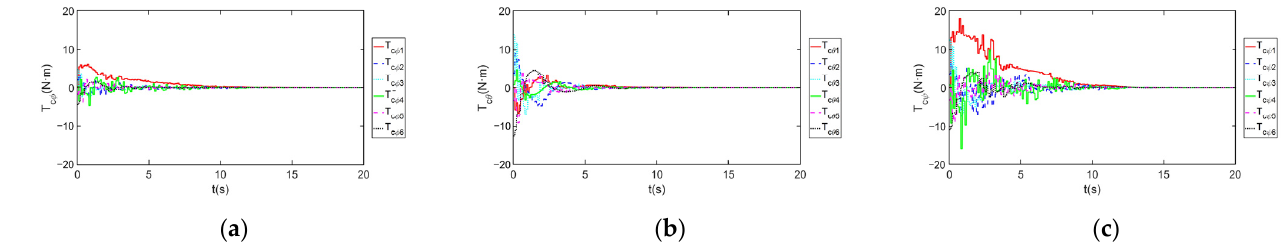
Figure 9. The control torque for the swarm utilizing SRP systems or NP systems: ( a ) Roll torque; ( b ) Pitch torque; ( c ) Yaw torque.